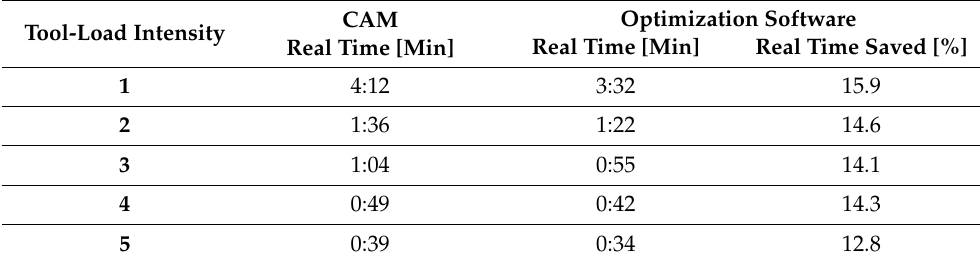
Table 9. Real machining times and real-time